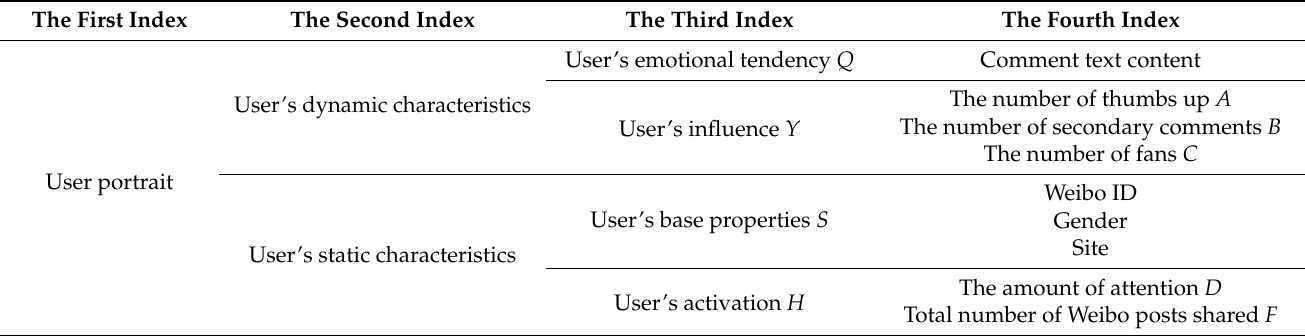
Table 2. User characteristic index